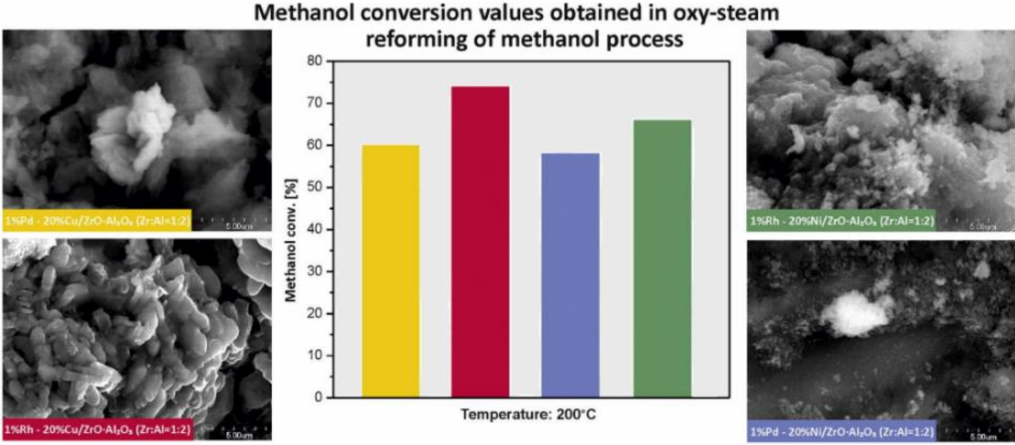
Figure 8. The activity results of Rh(Pd)-Cu(Ni) / ZrO 2 · Al 2 O 3 (1:2) catalysts in the OSRM process